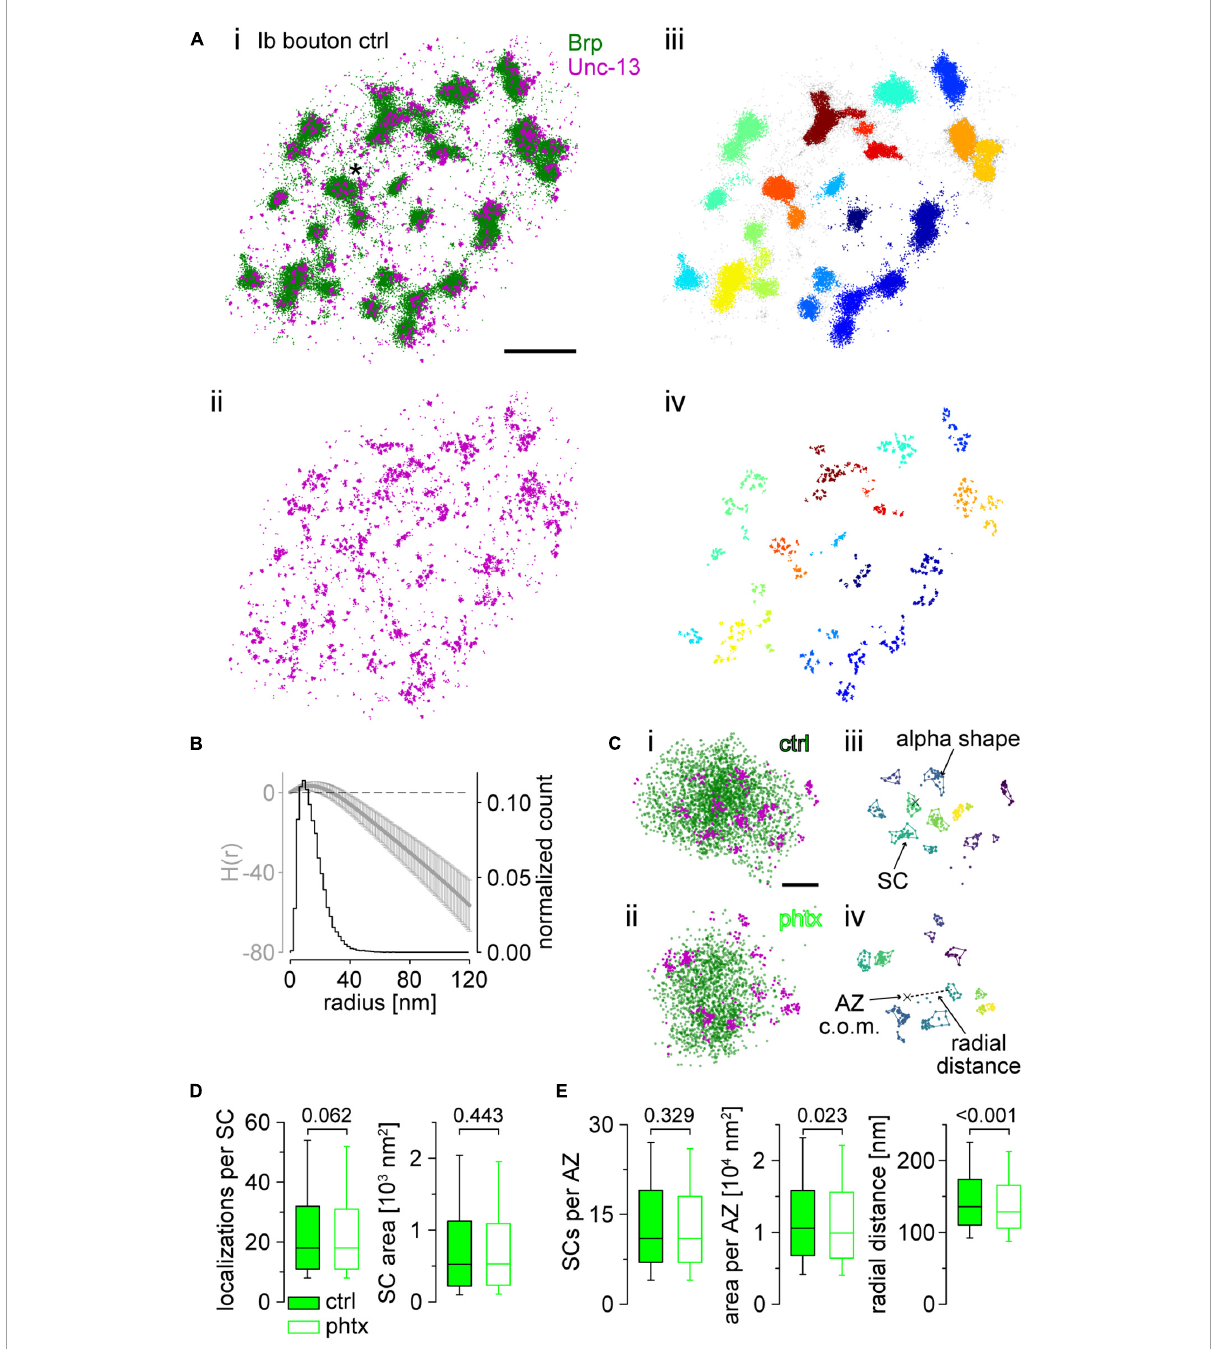
FIGURE4 Super-resolution imaging of Unc-13 GFSTF at presynaptic active zones (AZs) reveals nanoscale reorganization in presynaptic homeostatic potentiation (PHP). (A) Scatter plots of two-channel direct stochastic optical reconstruction microscopy ( d STORM) localizations of an unc-13 GFSTF type Ib bouton from a control (ctrl) animal co-stained with α -green fluorescent protein ( α -GFP) antibody labelled with Alexa Fluor647 conjugated F(ab’) 2 fragments for visualization of Unc-13 GFSTF (magenta) and Brp Nc82 labelled with Alexa Fluor532 conjugated IgGs (green). (Ai) Overlay of the two channels. Asterisk marks the enlarged region in (Ci) . (Aii) Red channel showing Unc-13GFSTF localizations of the same bouton as in (Ai) . (Aiii) Brp localizations from (Ai) with clusters extracted by HDBSCAN and individual AZs in different colors. Unclustered localizations are shown in gray. (Aiv) Unc-13GFSTF localizations from (Aii) with all localizations with euclidean distance > 20 nm to Brp localizations removed. The removed signal is considered noise. Individual Unc-13 GFSTF subclusters (SCs) were extracted by HDBSCAN and assigned to nearest AZs by color. (B) Averaged H function (black, mean ± SD) from n = 2,040 Unc-13 GFSTF first level clusters obtained from 22 NMJs from nine animals (maximum of the curve indicates a mean sc. radius of 13 nm) and histogram (gray) of the mean radius